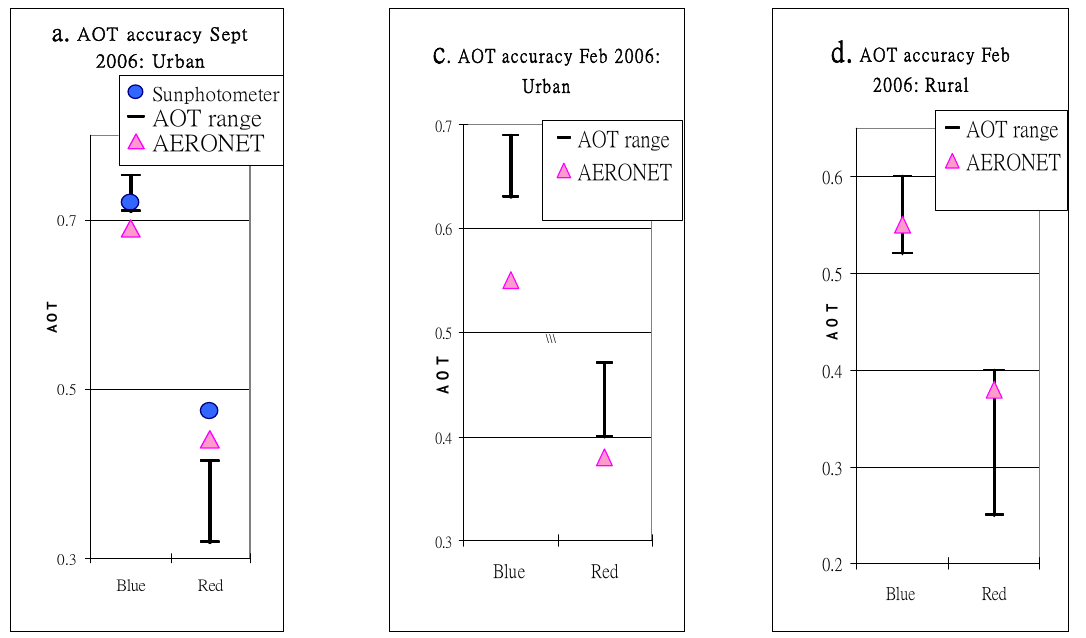
Figure 5 . Image AOT on 27-Sep-2006. a) Urban, and b) Rural, and on 7-Feb-2006, c) Urban and d) Rural, compared with AERONET and Microtops II sunphotometer data. AOT range represents 1 s.d.